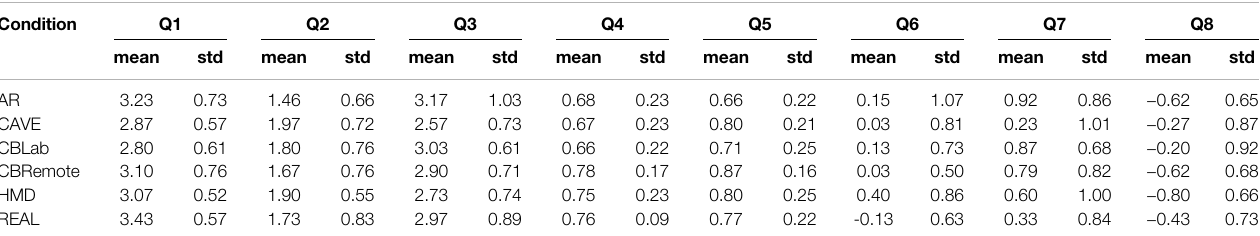
TABLE 4 | Summary of questionnaire data. See Figure 10 for questions wordings. Condition